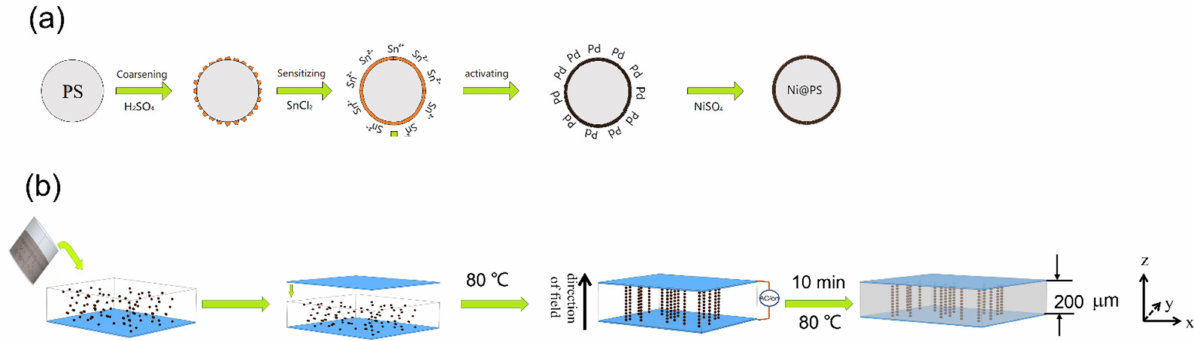
Figure 1. Schematics of preparing of Ni@PS microspheres ( a ) and aligned Ni@PS/EP composites ( b ).